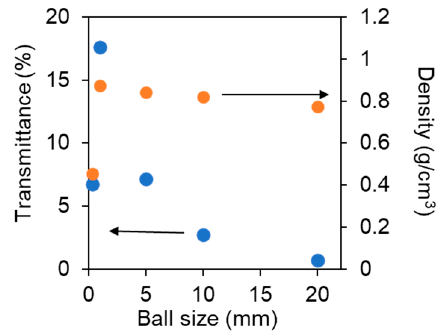
Figure 2. Dependence of transmittance at 600 nm (blue circle) and density (orange cercle) of the cast film on different ball sizes for milling of chitin.